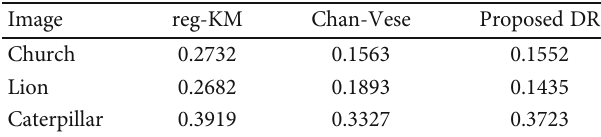
Table 1: Comparison of reg-KM, Chan-Vese algorithm, and proposed DR algorithm in terms of BCE ∗ error.